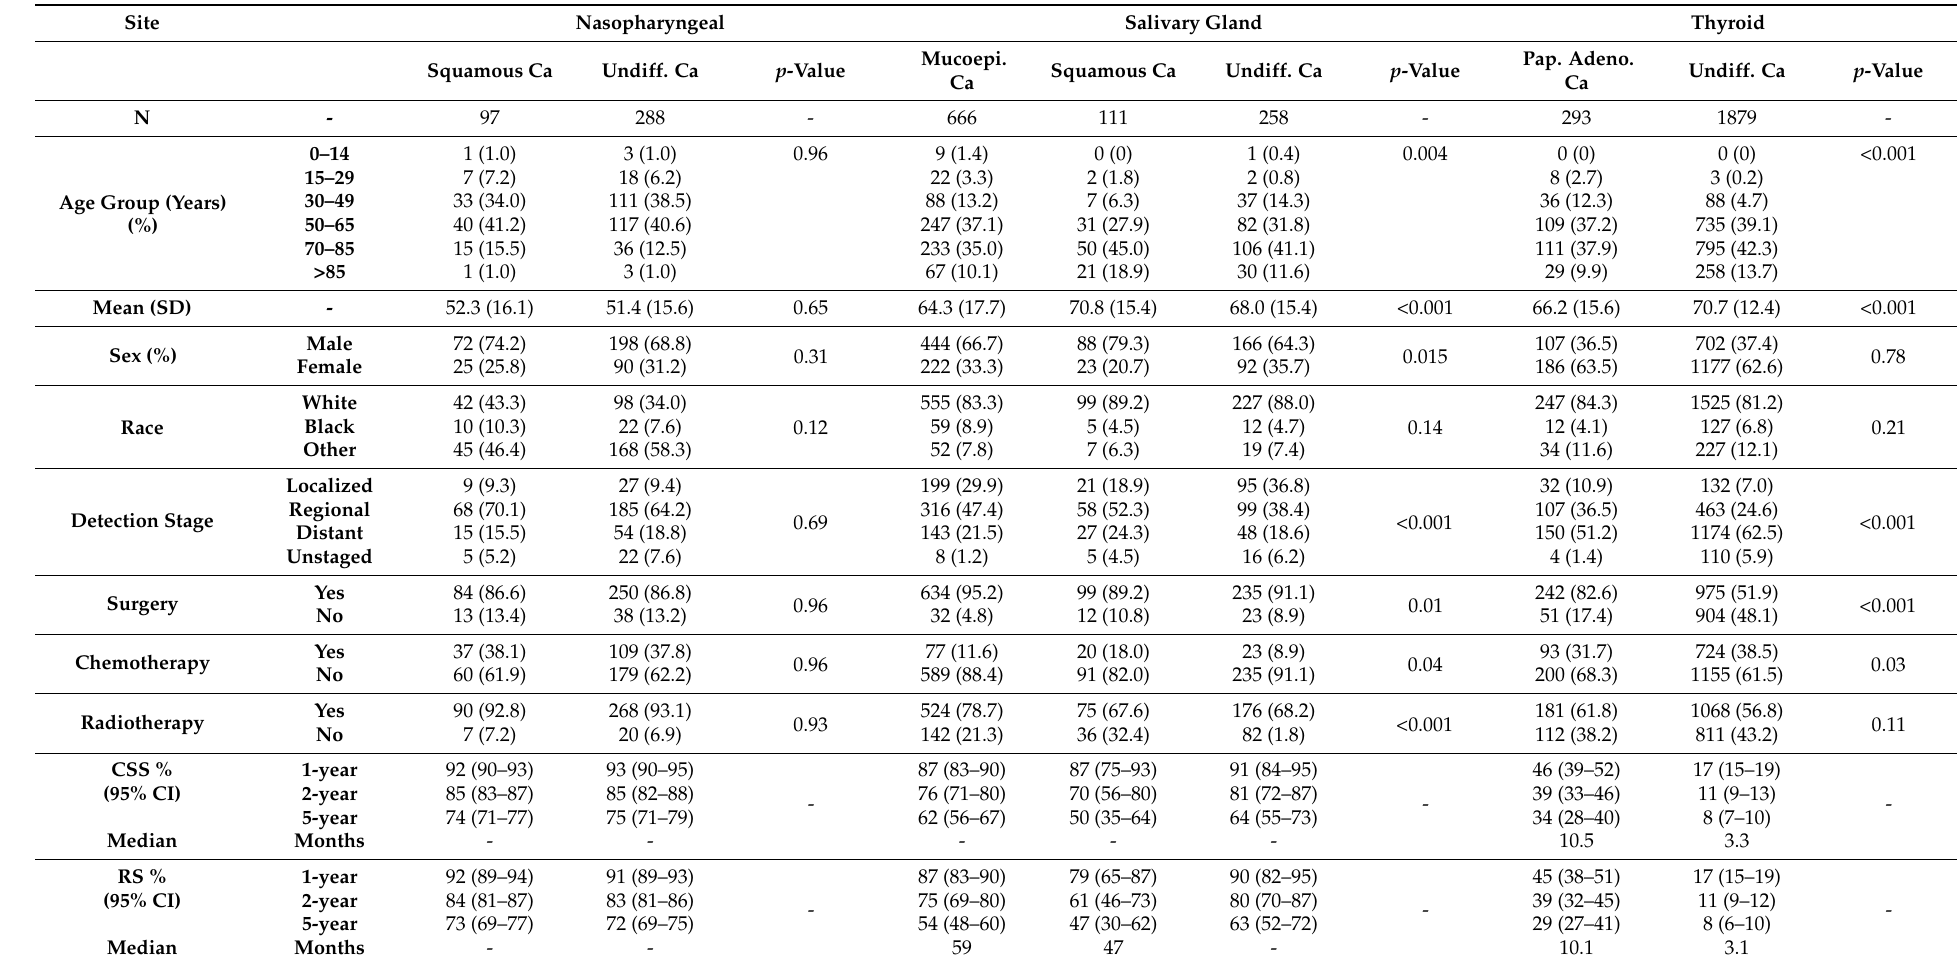
Table 1. Baseline demographics and clinical characteristics by histology for included